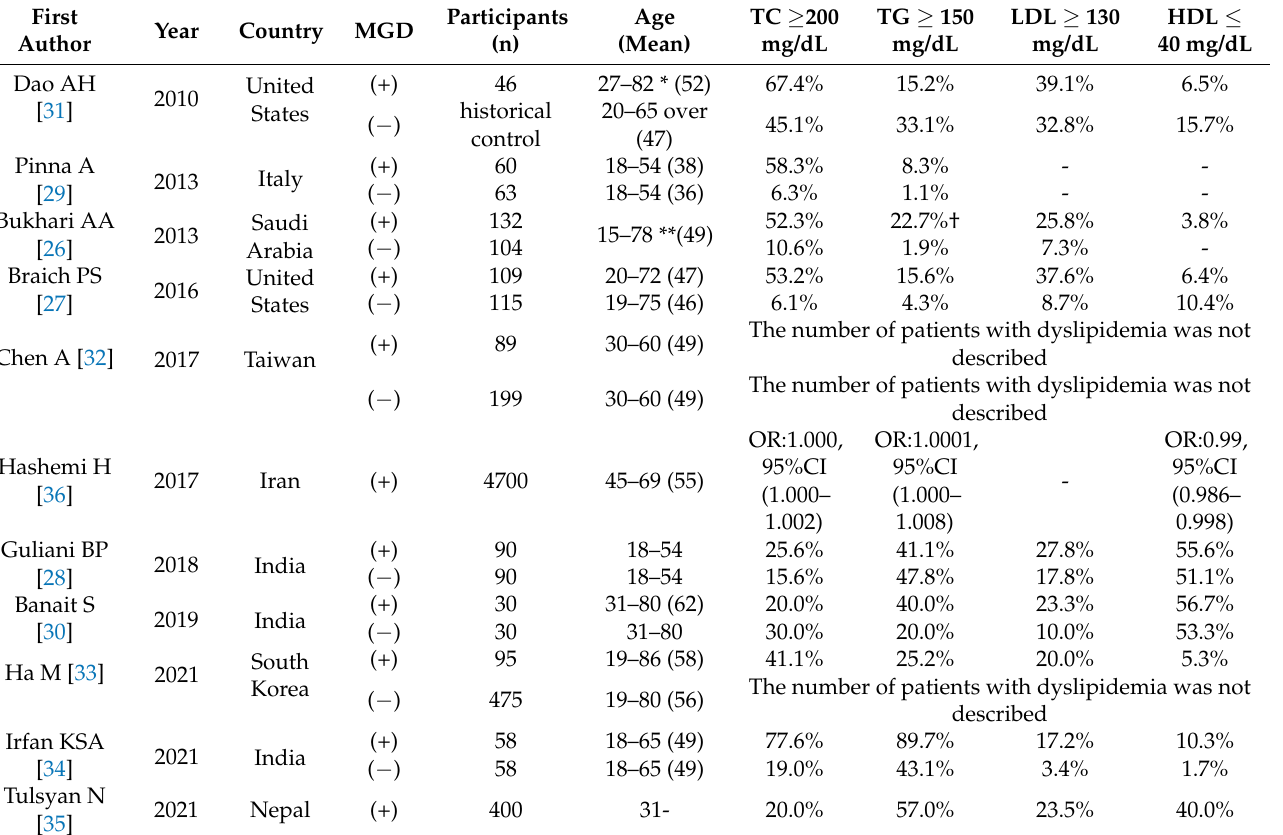
Table 4. Summary of dyslipidemia in patients with or without meibomian gland